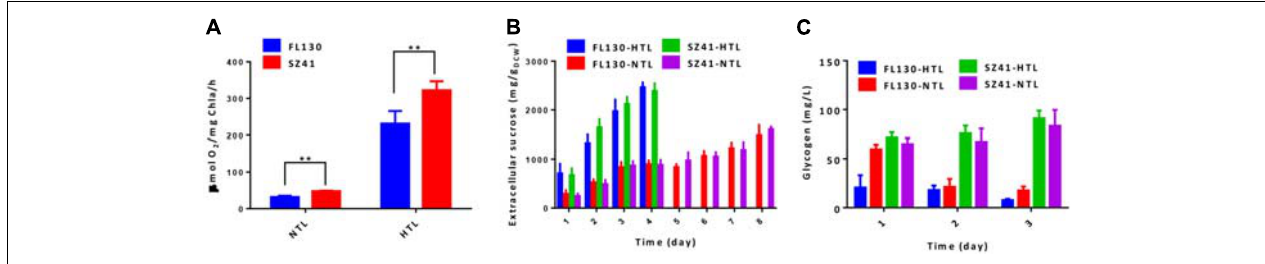
FIGURE 4 | Effects of the AtpA-C252F mutation on carbohydrate production of a PCC 7,942 derived cell factory. (A) Oxygen evolution rate of the FL130 and SZ41 strains under normal (NTL, 30 ◦ C with 100 µ mol photons/m 2 /s illumination) and stressful (HTL, 40 ◦ C with 400 µ mol photons/m 2 /s illumination) conditions. (B) Specific sucrose productivities of the FL130 and SZ41 strains under normal (NTL, 30 ◦ C with 100 µ mol photons/m 2 /s illumination) and stressful (HTL, 40 ◦ C with 400 µ mol photons/m 2 /s illumination) conditions. (C) Glycogen accumulation of the FL130 and SZ41 strains under normal (NTL, 30 ◦ C with 100 µ mol photons/m 2 /s illumination) and stressful (HTL, 40 ◦ C with 400 µ mol photons/m 2 /s illumination) conditions during the initial 3 days of cultivation. Error bars indicate standard deviations ( n ≥ 3). Statistical analysis was performed by using Student’s t -test (** p <